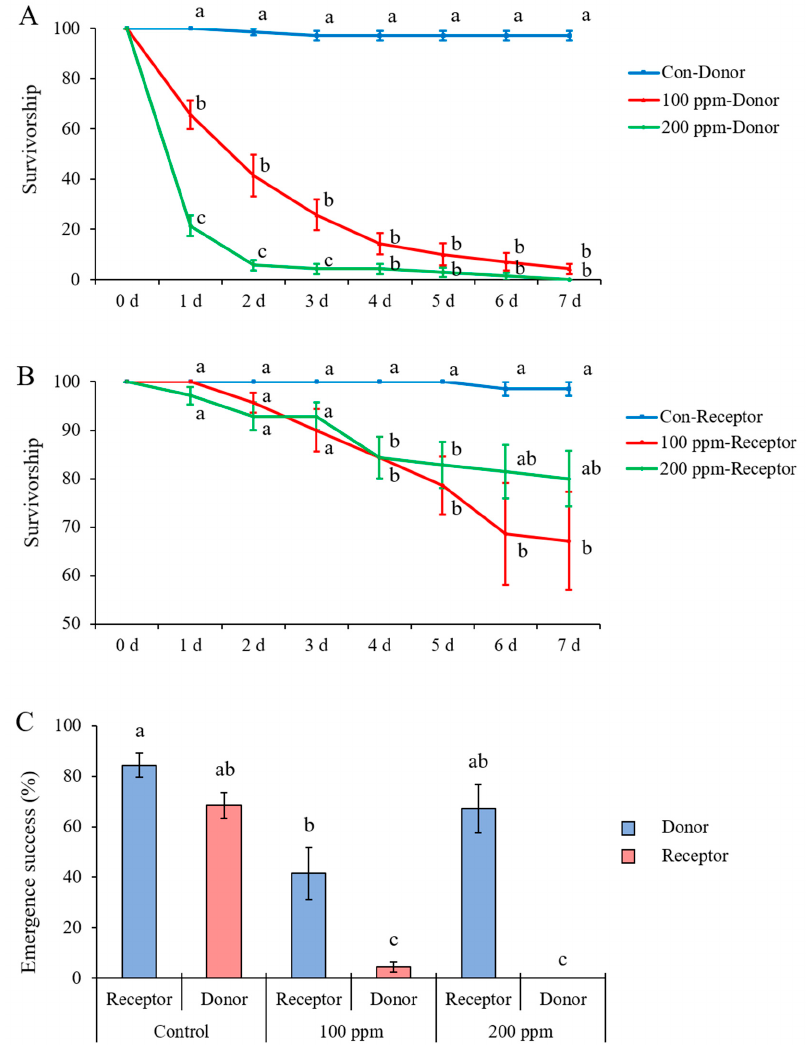
Figure 7. ( A ) Larval survivorship of donors ( B ) and receptors and ( C ) emergence success of adults